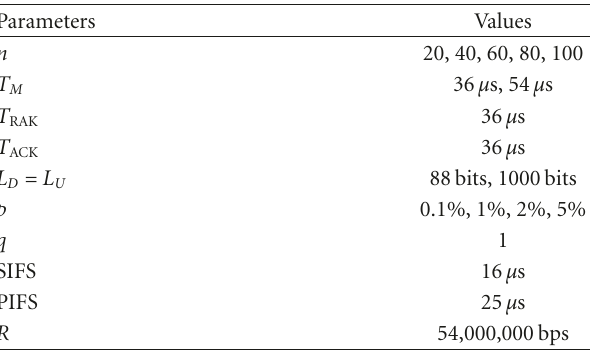
Table 2: Values of parameters used for numerical examples. Parameters